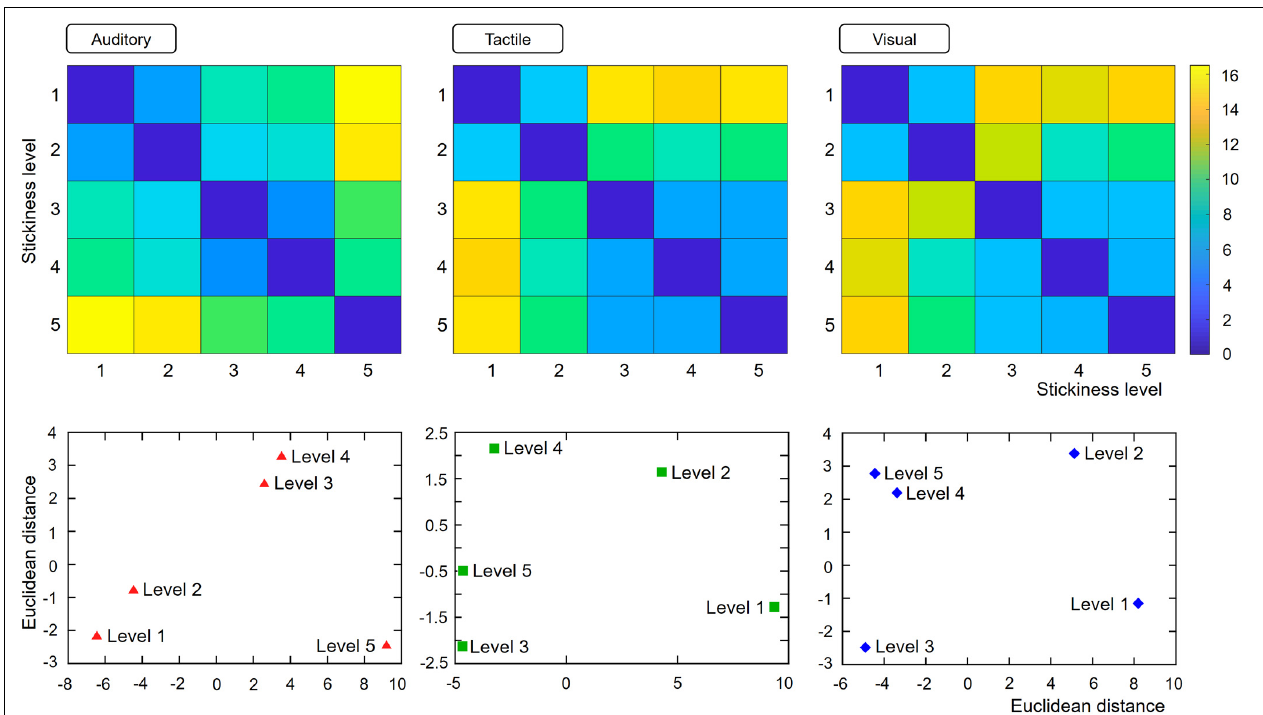
FIGURE 3 | Results of the magnitude estimation task. Distance matrices for each modality condition were computed based on the perceived difference of stickiness intensities. The values in each cell indicate the perceptual distances of each stimulus pair. Based on these values, relative positions of the five stickiness intensities were computed and depicted in a 2-dimensional MDS